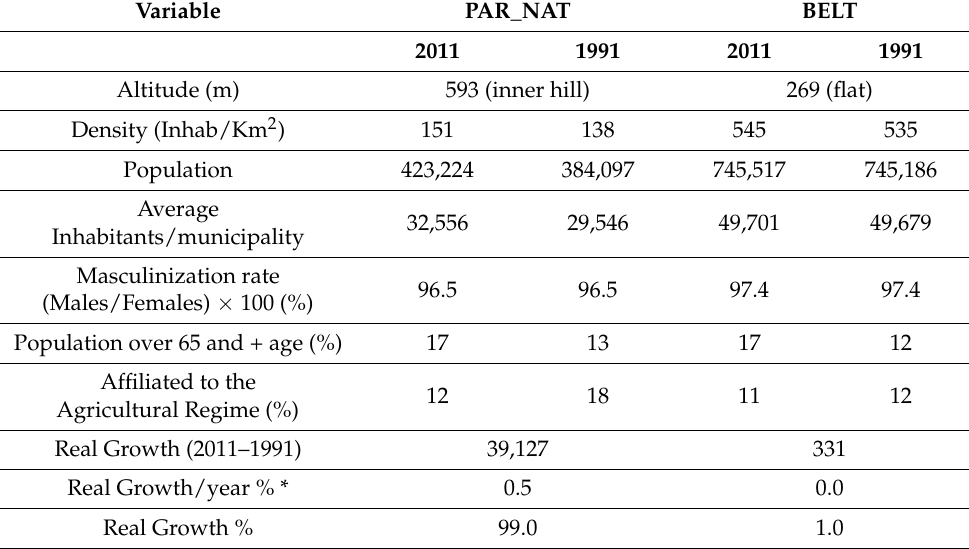
Table 2. Alta Murgia Park: territorial framework of the